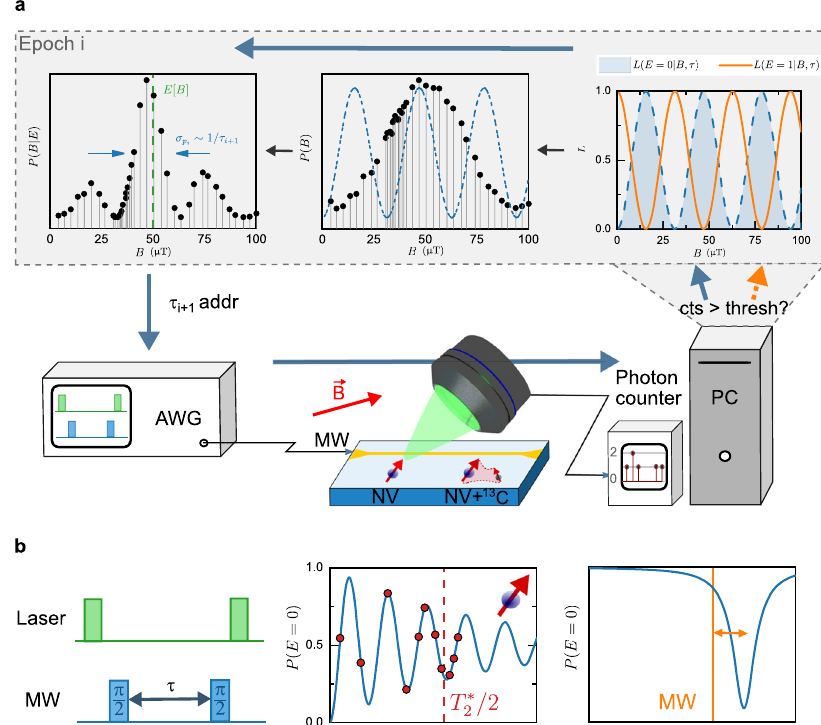
Fig. 1 Fast feedback for adaptive MFL. a The AWG generates the Ramsey sequence that is applied to the NV. Optical initialization and readout are performed with a confocal microscope. Photoluminescence photons are counted by a single photon counter. In every epoch of the MFL, the result of the Ramsey sequence is analyzed by comparing it to a pre-characterized threshold. The likelihood function L ( E | B , τ ) (dashed blue and orange line in the fi rst row) is chosen depending on the measured eigenstate of the NV and multiplied according to Bayes ’ rule to the prior distribution P ( B ). From the resulting posterior P ( B | E ), the current expectation value (dashed green line in the fi rst row) for the magnetic fi eld and the Ramsey phase evolution time of the next epoch (based on the peak width indicated by blue arrows) are calculated. The lab computer outputs the AWG memory address of the corresponding sequence to complete the feedback loop. b , Left: pulse sequence for a Ramsey experiment. Laser pulses are used for initialization and readout of the NV. Phase is acquired between the two microwave π /2 pulses. Middle: Sketched result for a single NV in the time domain. The oscillation frequency encodes the magnetic fi eld intensity B . To optimize = 2 (red dashed line) at later epochs. Right: frequency domain representation of the Ramsey sensitivity, MFL preferably chooses τ close to T (cid:3) 2 experiment. The frequency of the π /2 pulses is indicated as an orange